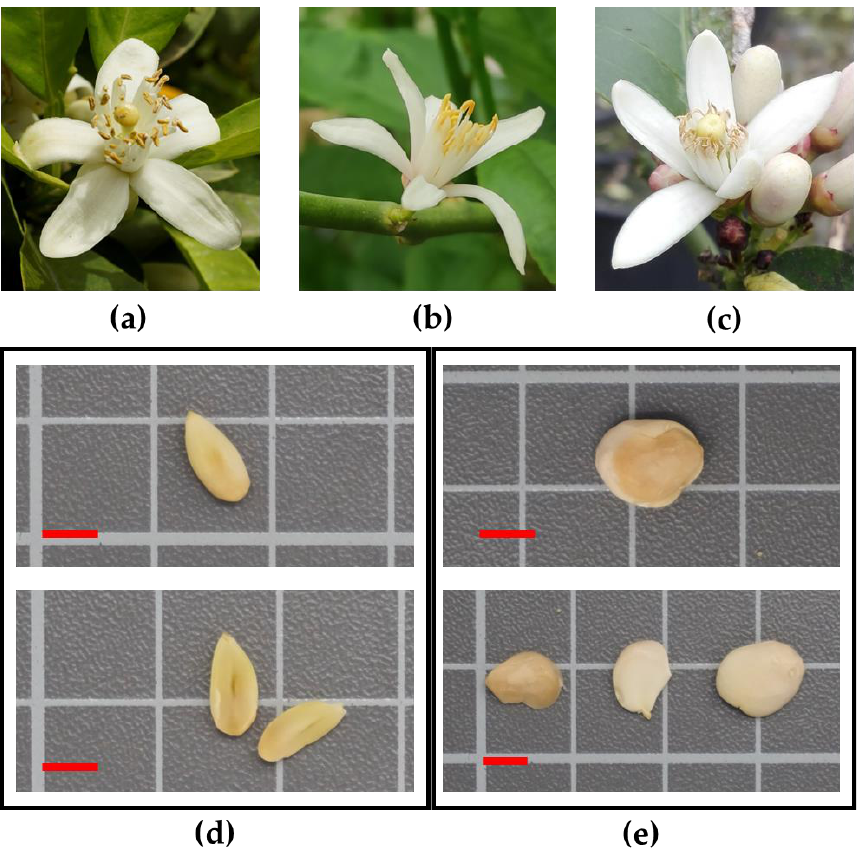
Figure 1. ( a ) Normal lemon flower; ( b ) lemon flower showing pistil abortion; ( c ) lemon flower showing atrophic (dry and whitish) anthers; ( d ) monoembryonic lemon seed; ( e ) polyembryonic lemon seed (bars are 0.5 cm). Table 2. SSR markers used in the present work for assessing seedlings of nucellar origin [37]. SSRs